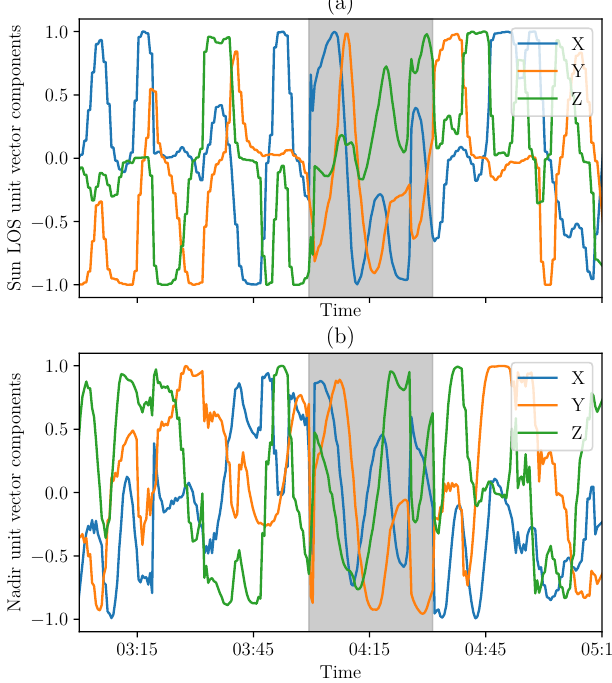
Figure 8. First lights of the Sun LOS ( a ) and nadir ( b ) components in the satellite body frame based on TRIAD method on 2 March 2021 (representative period in the case of measurements at 30 s intervals almost continuously, with eclipse phase in